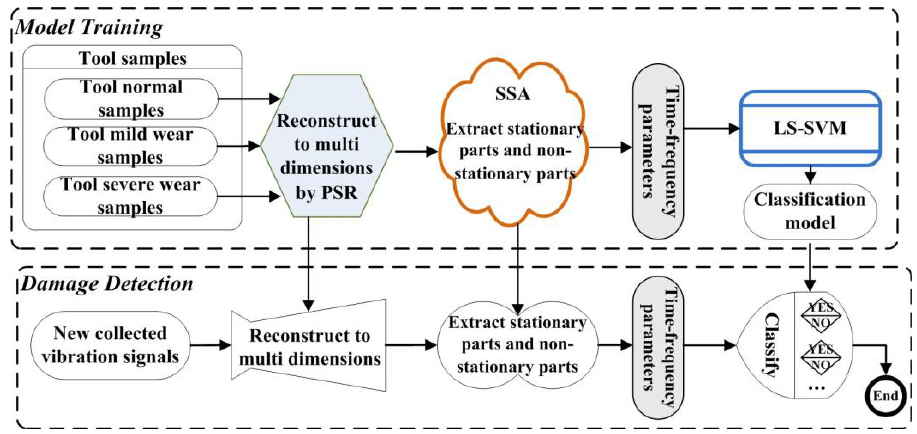
Figure 1. Damage diagnosis procedure based on hybrid Stationary subspace analysis, SSA: stationary subspace analysis, LS-SVM: least squares support vector machine. The process of the proposed SSA + LS-SVM method is described as Algorithm 3. Algorithm 3. Damage diagnosis approach based on SSA + LS-SVM Step 1: Model